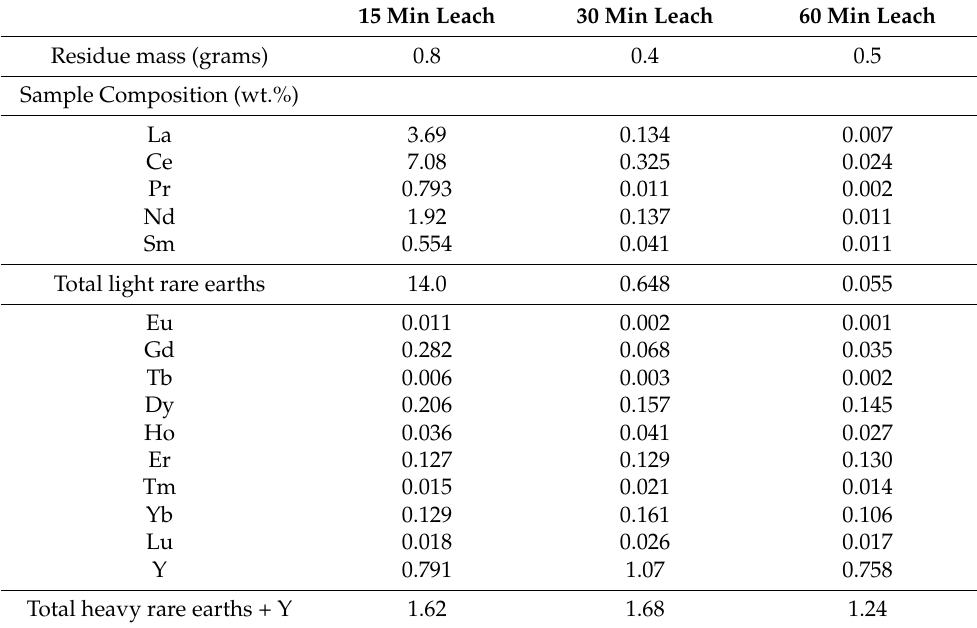
Figure 6. XRD diffractogram: Residue from 60 min leach, Perth monazite. To confirm insights from the XRD and leach recovery analysis, the solid assay of the residues is provided in Table 3. The mass of residue remaining after 15 min is almost twice that remaining for the 30 and 60 min leaches, indicating the higher overall dissolution of the concentrate with increasing leach time. Table 3. Rare earths: Mass and elemental composition of residues, Perth monazite (6.0 g